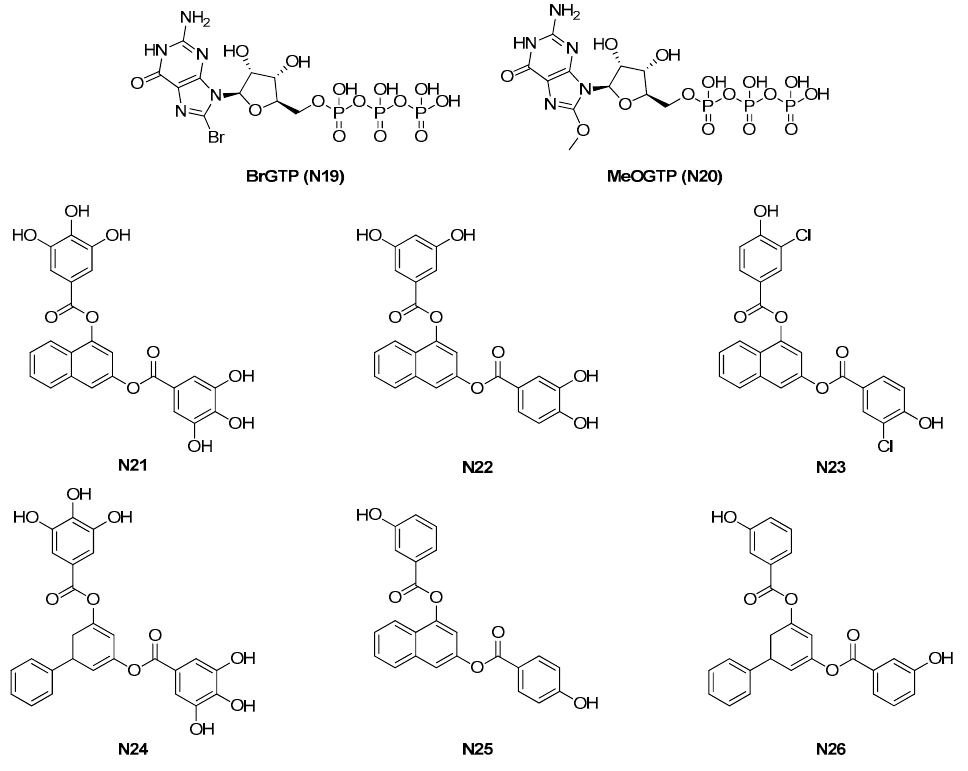
Figure 6. GTP analogues and derived synthetic FtsZ inhibitors.